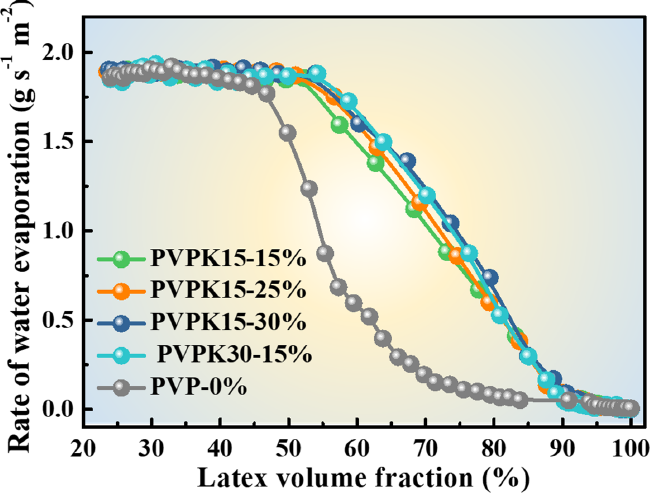
Figure 4. The influence curve of PVPK15 and PVPK30 dosage on the drying rate of